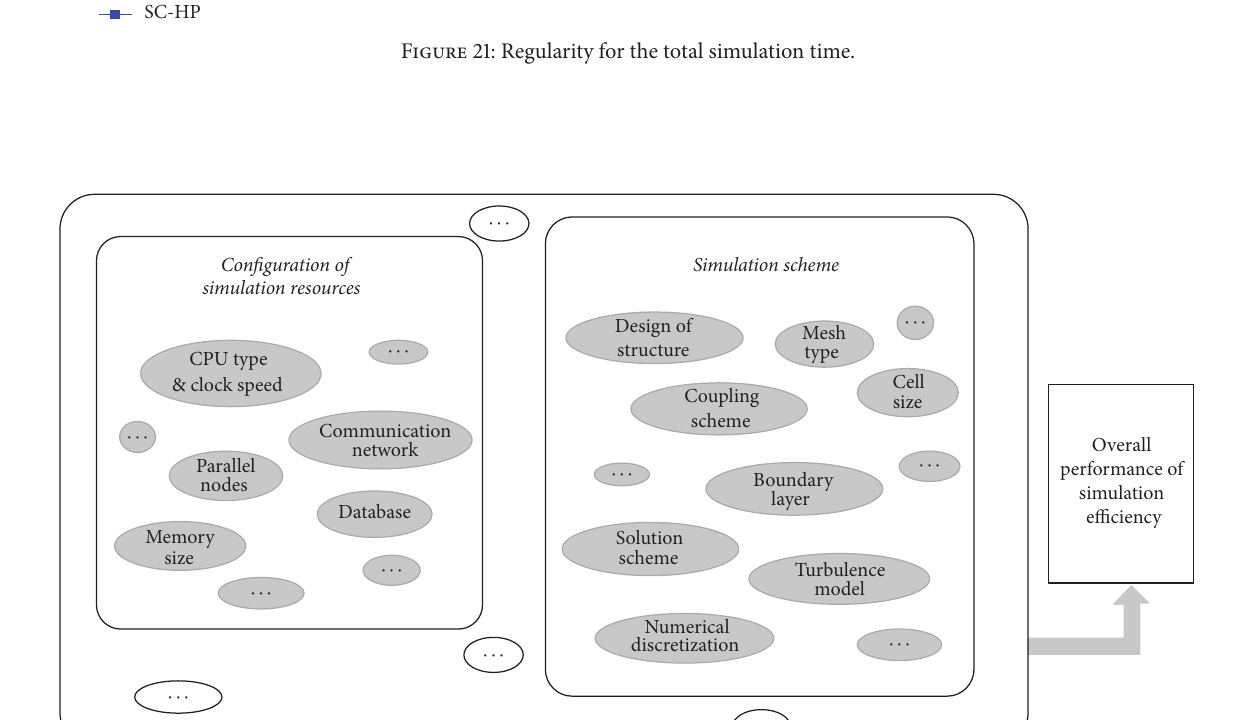
Figure 22: Influence factors on the overall performance of the simulation